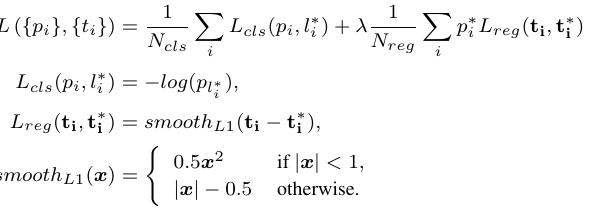
discriminative representations for classification and